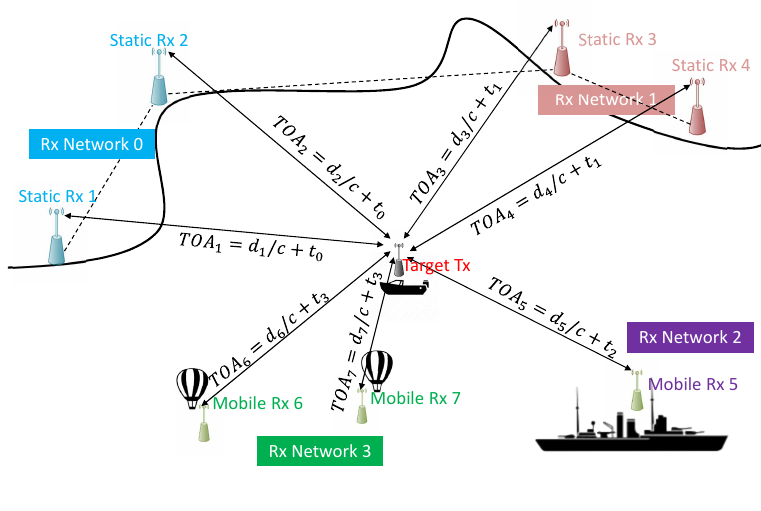
Figure 1. Typical scenario for Multi Network Time Difference of Arrival (TDOA). The four receiving networks (which include heterogeneous receivers) are not synchronised with each other ( t 0 (cid:54) = t 1 (cid:54) = t 2 (cid:54) = t 3 ). In this case, the traditional TDOA algorithm would lead to unbearable positioning